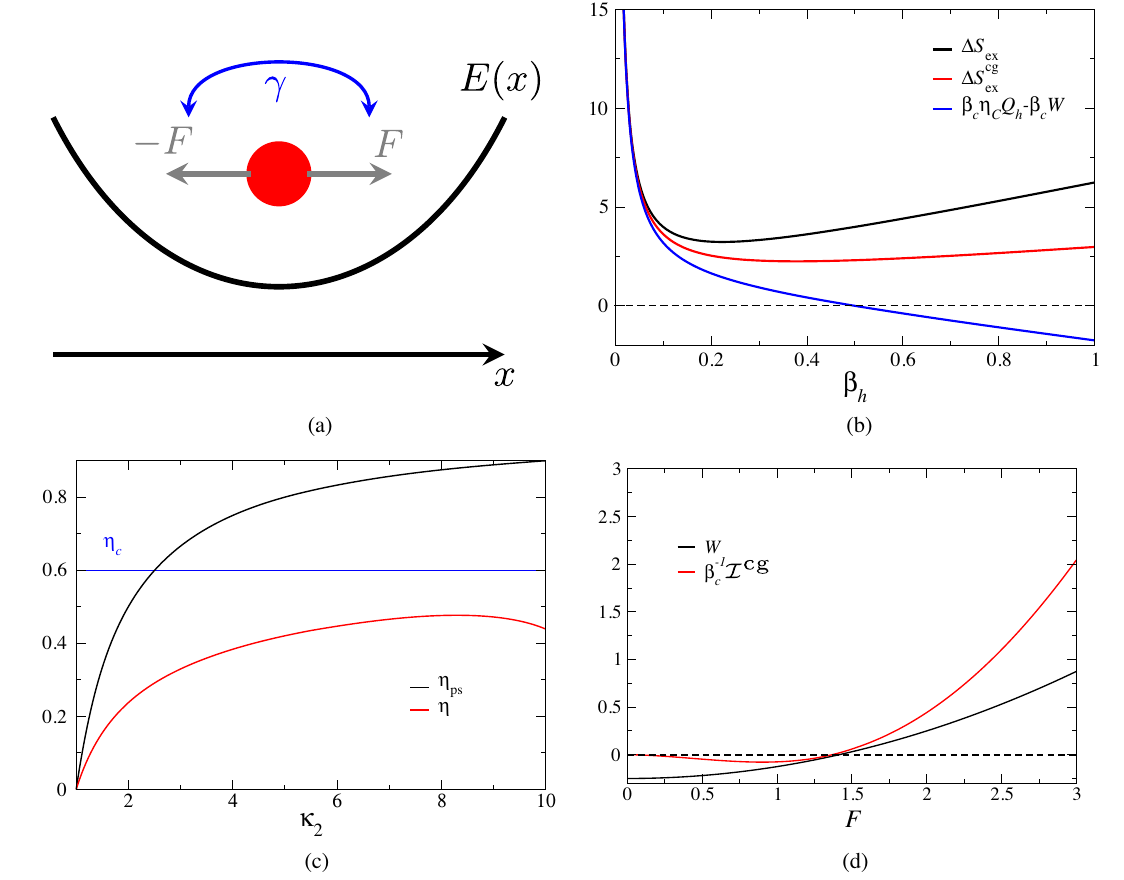
FIG. 5. (a) Depiction of an active particle with a force F that changes sign with a rate γ and in a harmonic potential E ð x Þ . (b) The quantities β c η C Q h − β c W , which can be negative for an active heat engine, Δ S cg ex , and Δ S β κ 2 and F ¼ 4 . (c) Efficiency η and pseudo-efficiency η ps as functions of κ h for 2 ¼ F ¼ 10 . (d) Work W and its upper bound ð β β 1 and κ 1 c ¼ 1 ¼